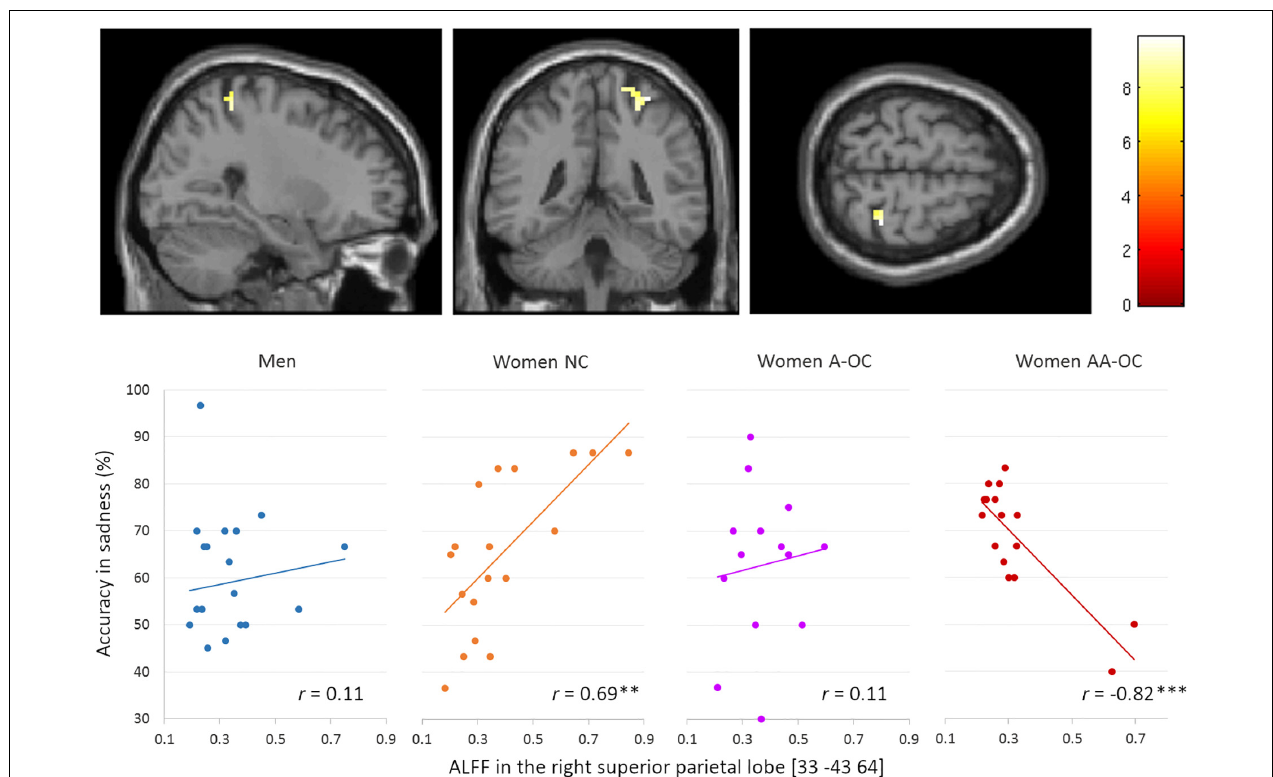
FIGURE 4 | Relationship between the amplitude of low-frequency fluctuations (ALFF) in the in the right superior parietal lobe and accuracy of sadness by group. ALFF and accuracy were found to be positively correlated for naturally cycling women, whereas they were negatively correlated for women on AA-OC. ** p < 0.01, *** p <